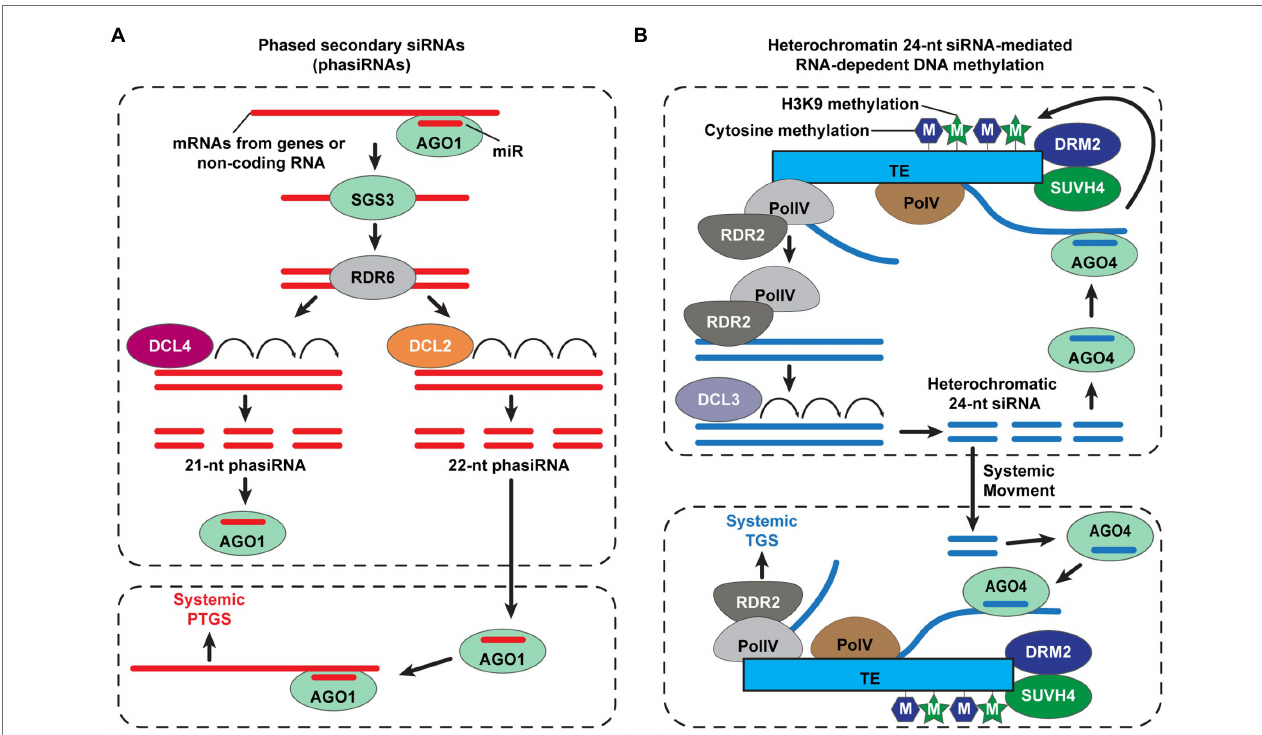
FIGURE 2 | Small interfering RNA (siRNA)-mediated systemic posttranscriptional and transcriptional gene silencing in plants. (A) Biosynthesis of phased secondary small interfering RNAs (phasiRNA) for systemic posttranscriptional gene silencing (PTGS) in plants. The ARGONAUTE1 (AGO1) loads a microRNA (miR) and then binds to mRNA transcripts of genes or non-coding RNAs to cleave the target RNAs. Double-stranded RNAs (dsRNAs) are synthesized by RNA-DEPENDENT RNA POLYMERASE6 (RDR6), with dependence on SUPPRESSOR OF GENE SILIENCING3 (SGS3); DICER-LIKE4 (DCL4) and DCL2 cleave long dsRNAs into 21- and 22-nt phasiRNAs, respectively. DCL2-dependent 22-nt phasiRNAs play a role in transitivity to amplify gene silencing signal for non-cell-autonomous systemic PTGS (Chen et al., 2010; Taochy et al., 2017; de Felippes and Waterhouse, 2020; Liu et al., 2020). (B) A simplified model of systemic transcriptional gene silencing (TGS), mediated by mobile 24-nt siRNAs. The RNA polymerase IV (Pol IV) initiates the transcription of transposable elements (TEs), and then PolIV-associated RNA- DEPENDENT RNA POLYMERASE 2 (RDR2) generates double-stranded RNAs. The heterochromatin 24-nt siRNAs are cleaved from these double-stranded RNAs by DCL3 and recruited into AGO4. The AGO4-siRNAs target transcripts at homologous TE loci, which are derived from PolV, and recruit de novo DNA methyltransferase (DRM2) and/or SU(VAR)3–9 homolog 4 (SUVH4) for methylation of cytosine and histone H3 Lys9 (H3K9), respectively (Chen and Rechavi,